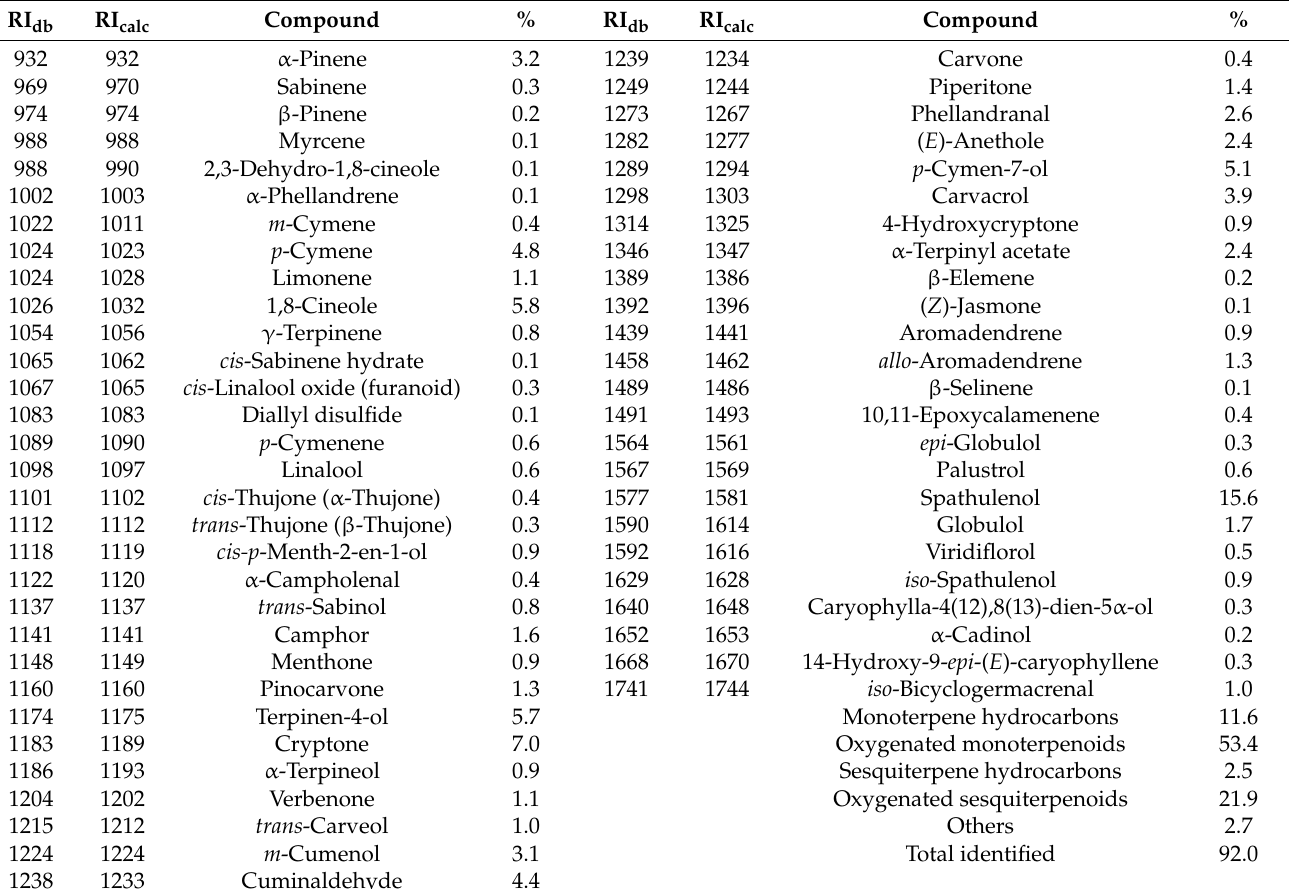
Table 1. Chemical profile of the essential oil extracted from Eucalyptus largiflorens leaves.